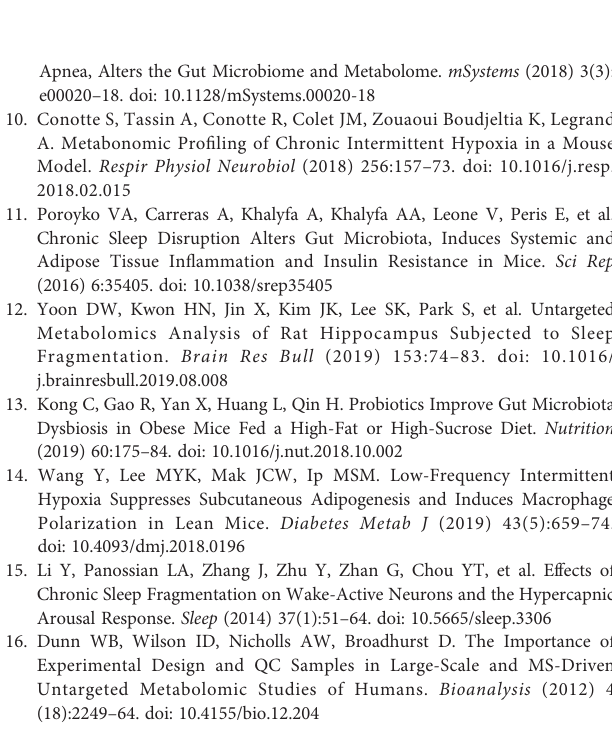
Supplementary Table S1 | Effects of CIH on the serum negative and positive metabolic ion peaks. Supplementary Table S2 | Effects of CSF on the serum negative and positive metabolic ion peaks. Supplementary Table S3 | Effects of CIH on the serum secondary metabolites. Supplementary Table S4 | Effects of CSF on the serum secondary